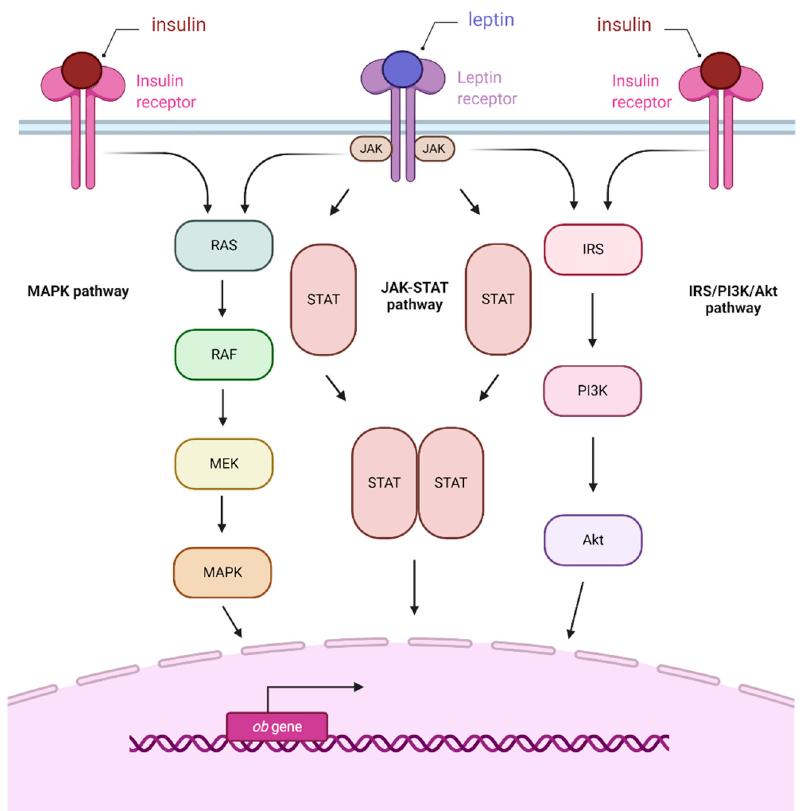
Figure 1. Pictorial diagram of insulin and leptin signaling in placenta which includes 3 major signaling pathways, namely JAK-STAT, MAPK, and IRS / PI3K / Akt. Abbreviations: Akt—protein kinase B; IRS—insulin receptor substrate; JAK—janus kinase; MAPK—mitogen-activated protein kinase; MEK—mitogen-activated protein kinase kinase; PI3K—phosphatidylinositol 3-kinase; RAF—RAF kinase; RAS—small GTPase; STAT—signal transducer and activator of transcription (according to References [38,39]) (Created with BioRender.com).